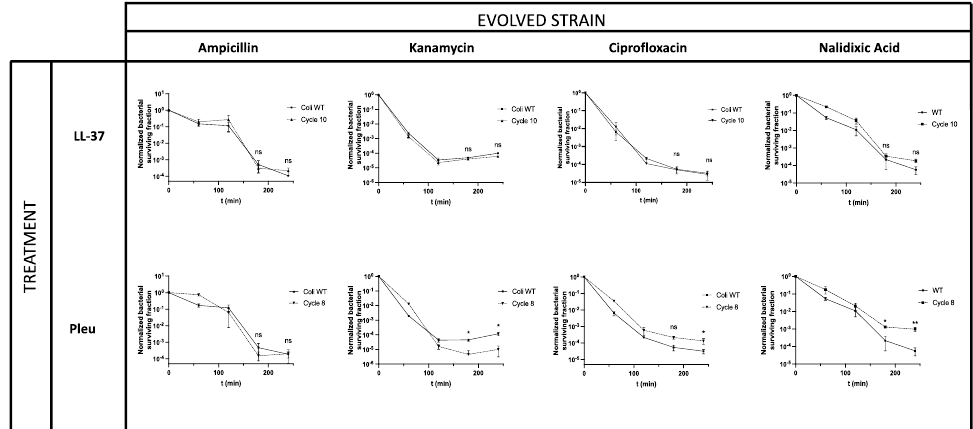
Figure 4. Killing curve assays after antibiotic exposure in E. coli strains evolved with Pleu and LL-37. Bacterial viability was measured as the relative number of surviving CFUs compared with the initial inoculum. The concentrations used for each antibiotic were 6.3 µg/mL for ampicillin, 12.5 µg/mL for kanamycin, 0.1 µg/mL for ciprofloxacin, and 20 µg/mL for nalidixic acid. Values are shown as the mean ± SEM, and all experiments were performed in triplicates. p -values are reported as indicated: ns : non-significant; * p < 0.05; ** p < 0.01.